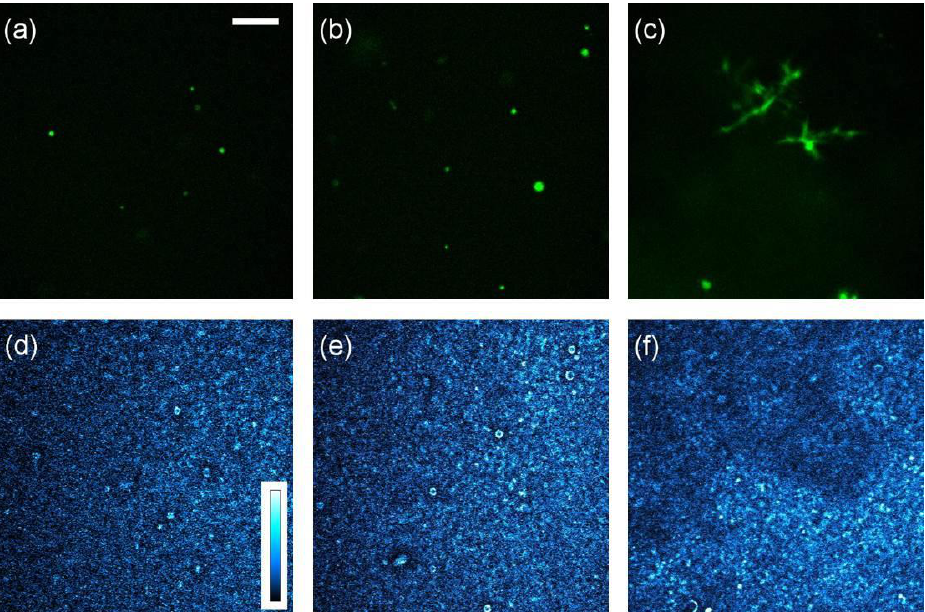
Fig. 3 Representative fluorescence (a–c) and SHG images (d–e) of tissue-engineered cartilage at low cell seeding density (2 × 10 5 cells/mL). SHG images are shown with the range between the maximum and the minimum intensity in each image to enhance the contrast. Images were acquired at 3 days (a, d), 8 days (b, e), and 15 days (c, f) after seeding. Scale bar = 100 